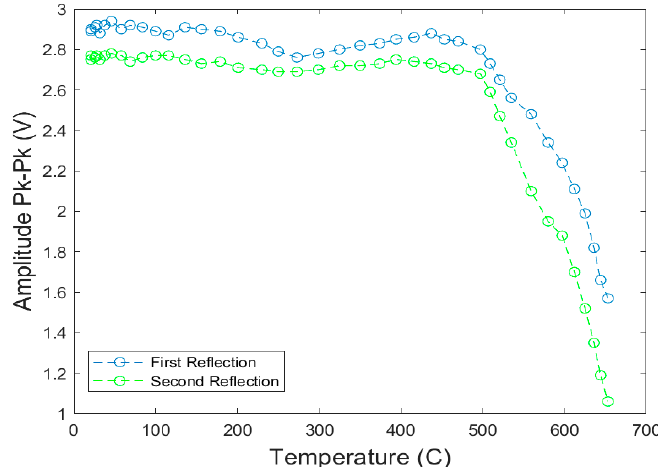
Figure 14. Signal amplitude (peak-to-peak) for the first two reflections as a function of temperature for bismuth titanate thick-film, spray-on transducer [7].